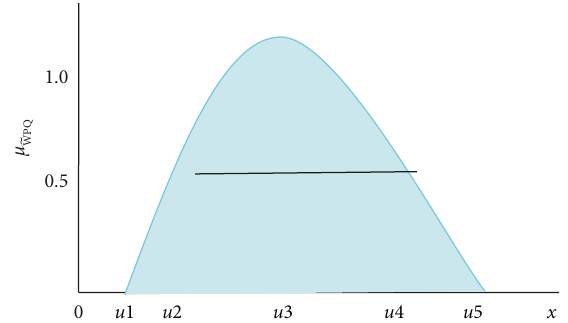
Figure 1: Graphical representation of a piecewise quadratic fuzzy number